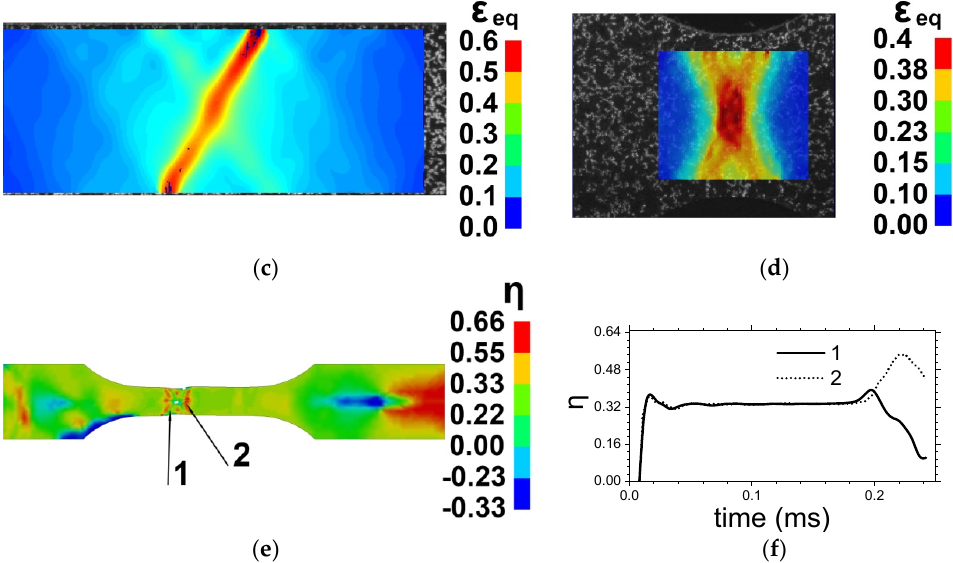
Figure 14. ( a ) Computed fields of the effective plastic strain for smooth specimens, ( b ) results for notched specimens with R = 5 mm; ( c ) experimental data obtained by digital image correlation (DIC) technique for smooth specimens of Ti ‐ 5Al ‐ 2.5Sn, ( d ) experimental data for specimens with the notch radius R = 5 mm, and ( e ) computed fields of the stress triaxiality factor. ( f ) Computed evolution of the stress triaxiality factor 1—in the fracture zone, 2—in the neck zone. The notch radius and maximum values of the stress triaxiality parameter have a large effect on the strain distribution over the specimen gauge part.